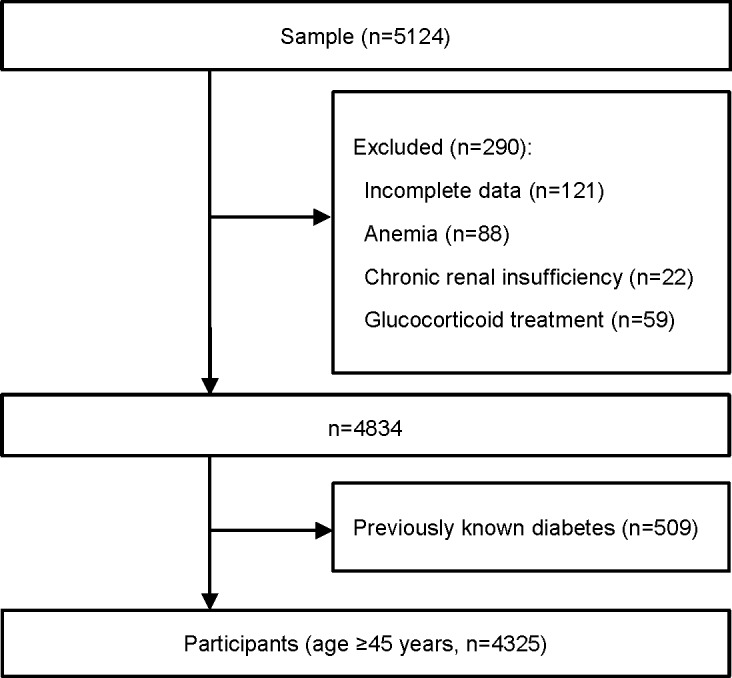
Flow diagram of the recruitment of participants.